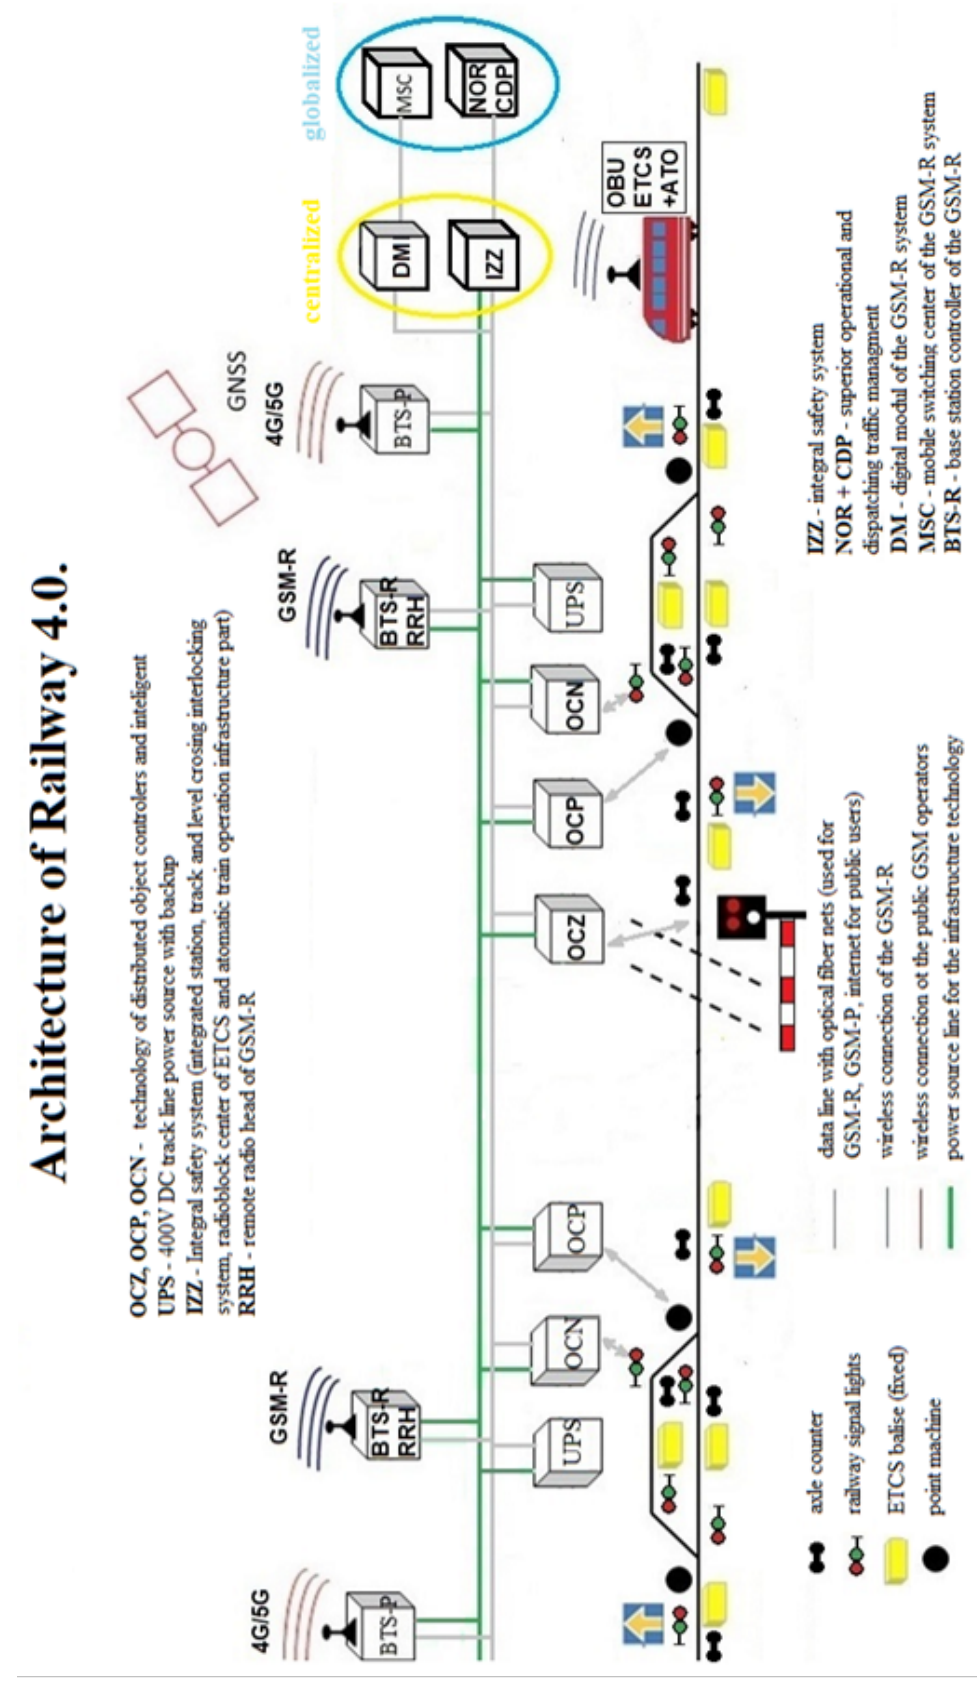
Figure 1. The Architecture of Railway